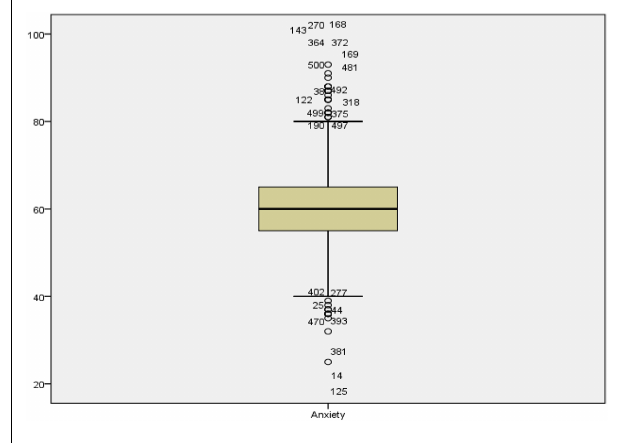
FIGURE 3 | The boxplot for anxiety.